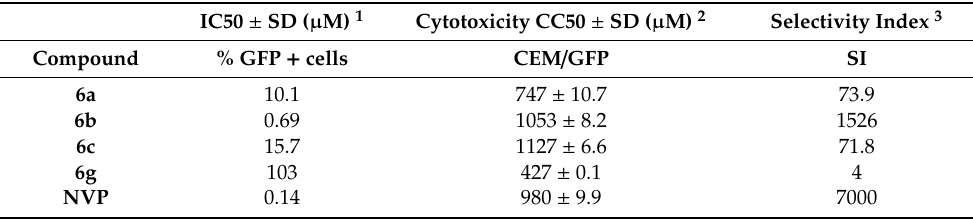
Table 2. Inhibitory activities against human immunodeficiency virus (HIV)-1 infection assayed by flow cytometry analysis of HIV-1 infected CEM cells harboring a plasmid of the green fluorescence protein under the control of HIV-LTR